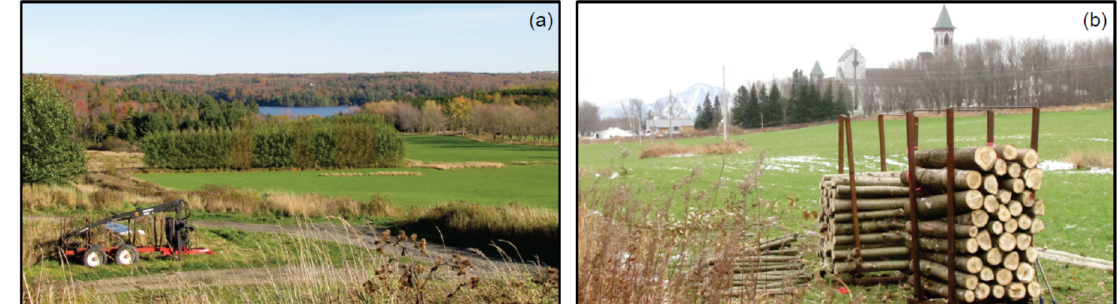
Figure 1. ( a ) 7-year-old bioenergy buffers located downslope of hayfields; ( b ) Hybrid poplar firewood log stacking in metal racks according to the different diameter classes. At the end of the study, firewood logs were used to heat the St-Benoît-du-Lac Abbey buildings.